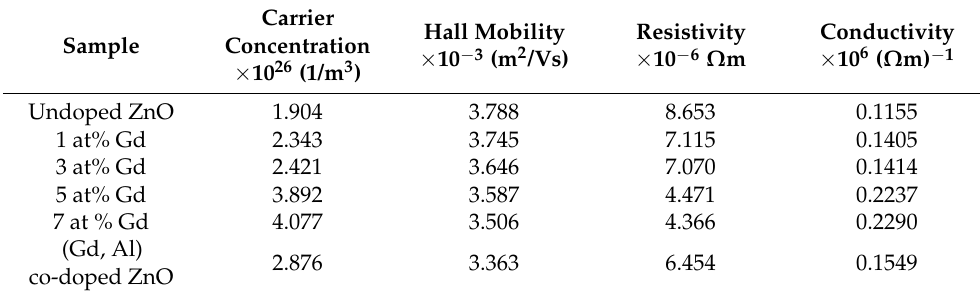
Figure 11. The variation of hall mobility, carrier concentration, resistivity, and conductivity as a function of ( a ) undoped ZnO and Gd ‐ doped ZnO films, ( b ) 3 at% Gd ‐ doped ZnO and 3 at% (Gd, Al) co ‐ doped ZnO films. Table 4. The electrical parameters of undoped ZnO, Gd ‐ doped ZnO, and 3 at% (Gd, Al) co ‐ doped ZnO films.